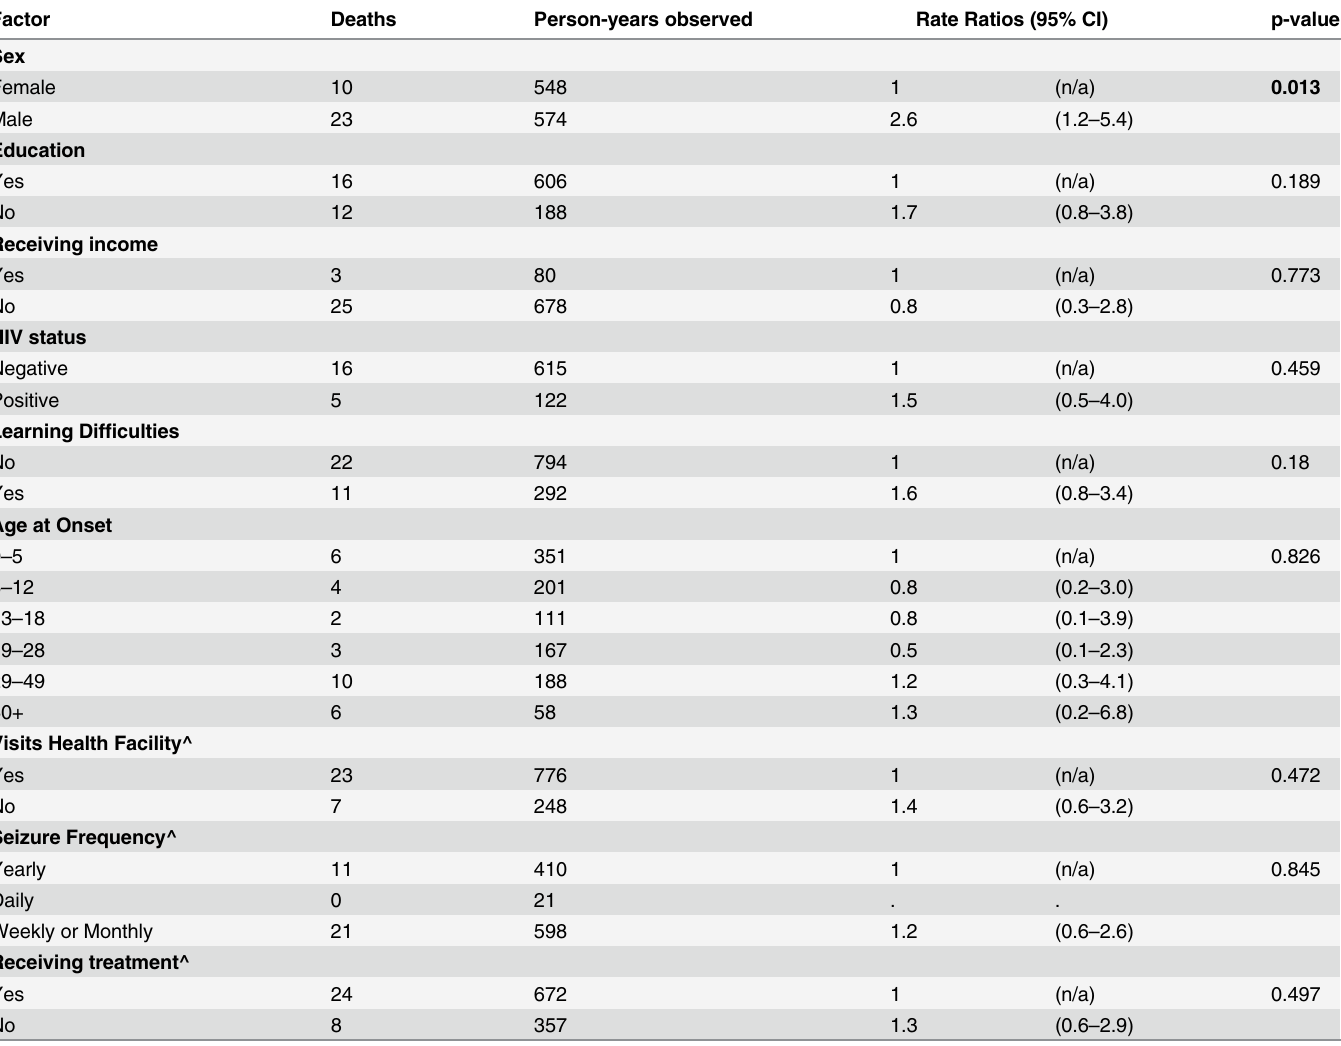
Table 5. Age-adjusted rate ratios for mortality in people with convulsive epilepsy, Agincourt 2008 –